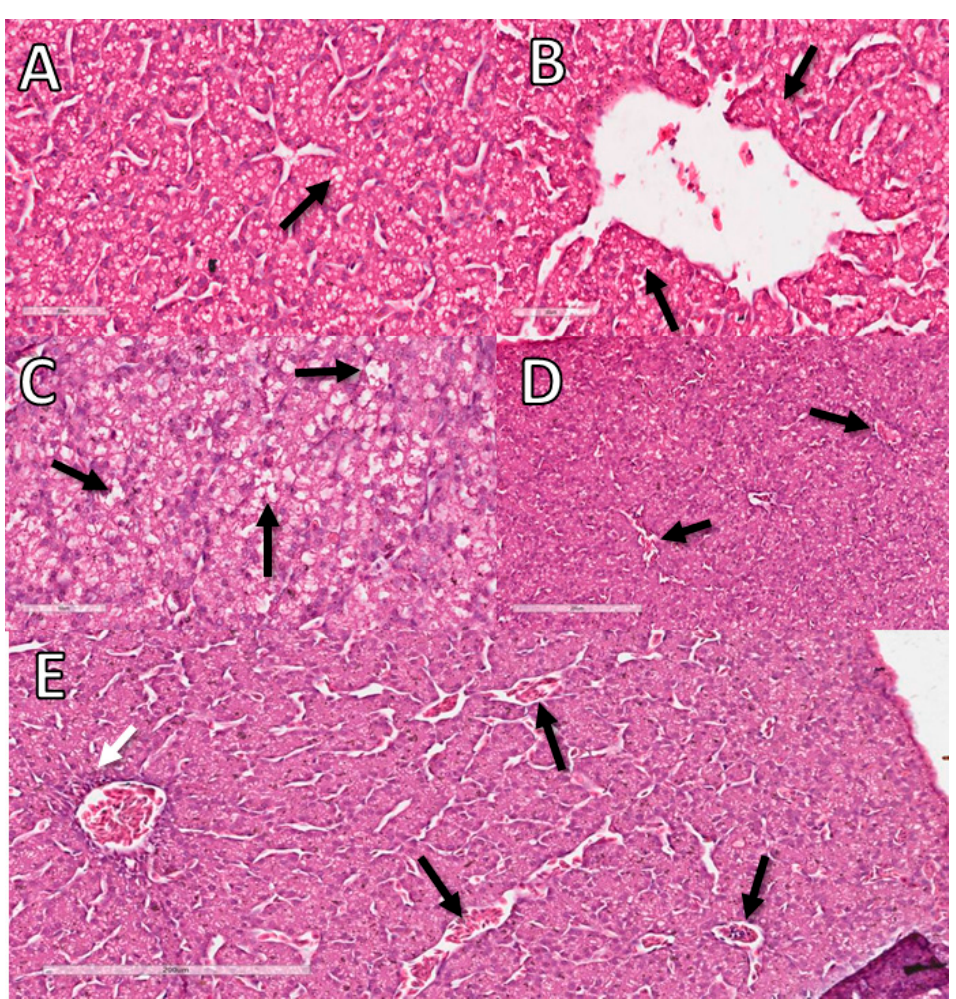
Figure 8. Histopathological analysis of the livers of CE treated with DX and FG at 10 EID. ( A ) CE liver sample from NC with a small amount of lipids in vacuoles in hepatocytes considered normal for comparison with the other groups (arrow). ( B ) Sample from the NC without inflammatory infiltrate (arrow). ( C ) DX-treated CE sample showing large cytoplasmic vacuoles in hepatocytes containing lipid characterizing lipid degeneration (arrow). ( D ) DX-treated CE sample with sinusoids filled with erythrocytes characterizing congestion (arrows). ( E ) FG-treated CE sample with perivascular inflammatory infiltrate (white arrow) and congestion (black arrows). The bars in images ( A – C ) represent 60 µm and the bars in images ( D , E ) represent 200 µm. The animals inoculated with FG at 10 EID showed an inflammatory process with infiltration of heterophils. Embryos inoculated with DX at 10 EID showed a mild inflammatory process and circulatory alteration and animals inoculated at 12 EID showed a mild inflammatory process and degeneration (lipidosis) (Table 10).